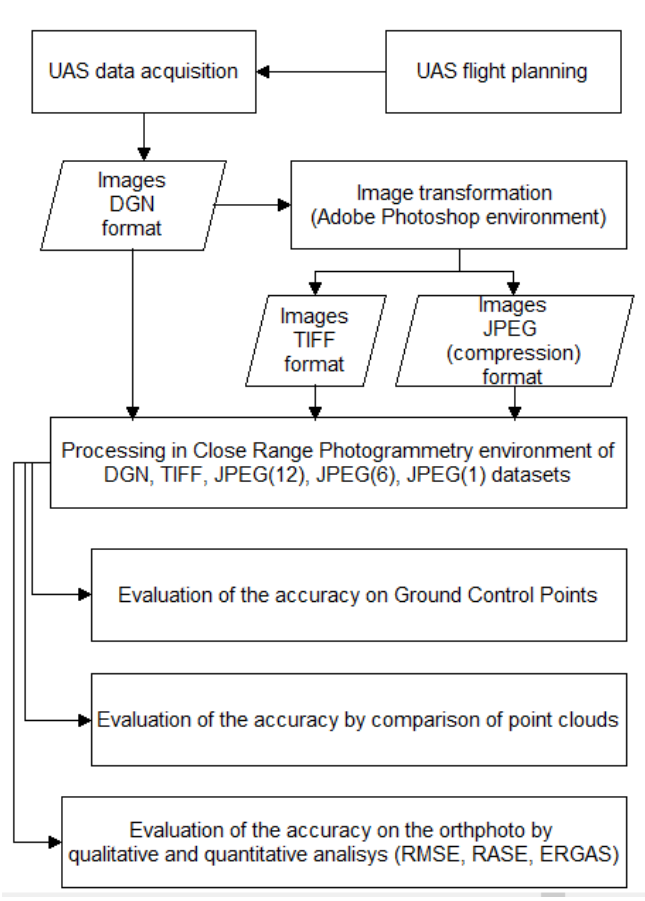
Figure 1. Pipeline of the developed method of investigation.